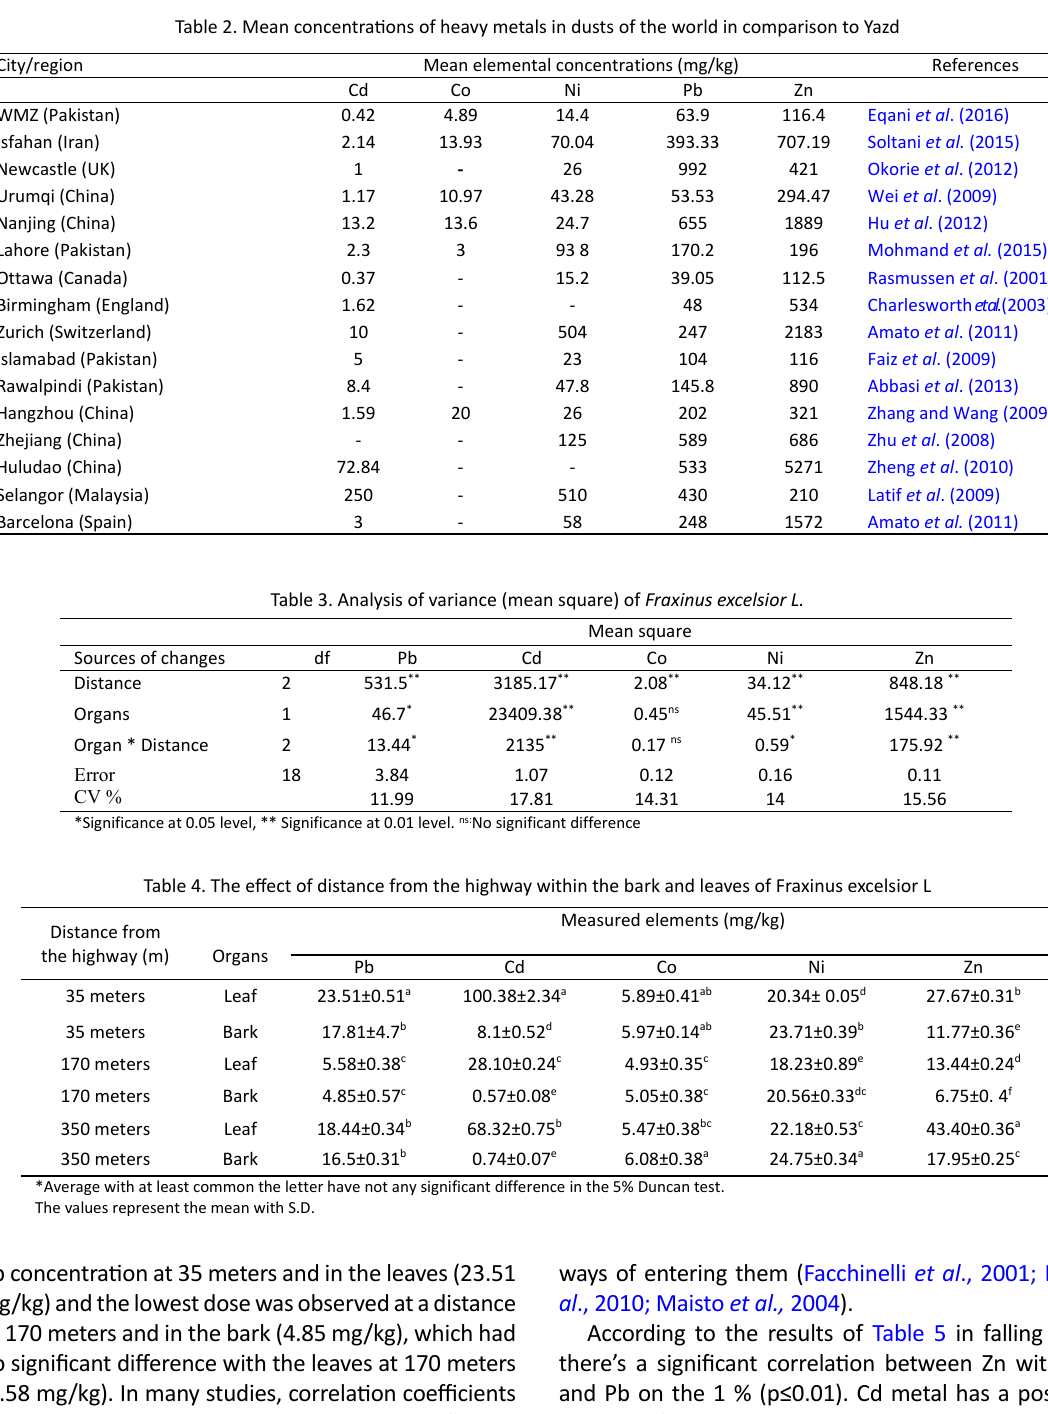
Table 2: Mean concentrations of heavy metals in dusts of the world in comparison to Yazd